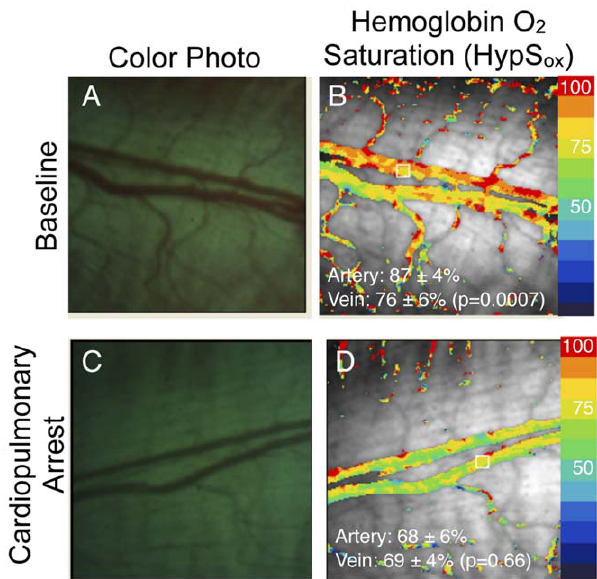
Figure 6. Hemoglobin oxygen saturation (HypS ox ) measure- ment before (A,B) and after (C,D) cardiopulmonary arrest. HypS ox measurements show significant desaturation of retinal artery and vein HypS ox within 15 minutes of cardiopulmonary arrest. Comparisons between artery and vein were made using paired, two- tailed Student T-test. Desaturation between arterial and venous measurements was significant between panels B and D (Artery: 87 6 4% versus 68 6 6%; p=0.00002, n=10; Vein: 76 6 6% versus 69 6 4%, p=0.03, n=10; paired, two-tailed Student T-test). pixel correlation of spectral intensity between Figure 7A and 7C revealed an excellent correlation with Bland-Altman analysis (Fig. 7E; Intraclass correlation coefficient 0.992) further supporting the lack of large spectral variations due to random spectral noise.